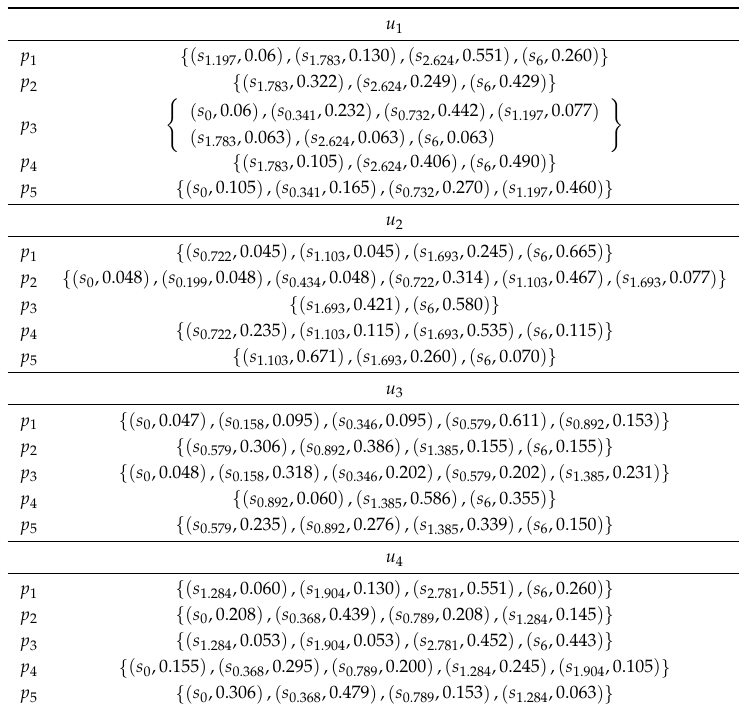
(cid:105) (cid:104) P ij ). H S 5 × 4